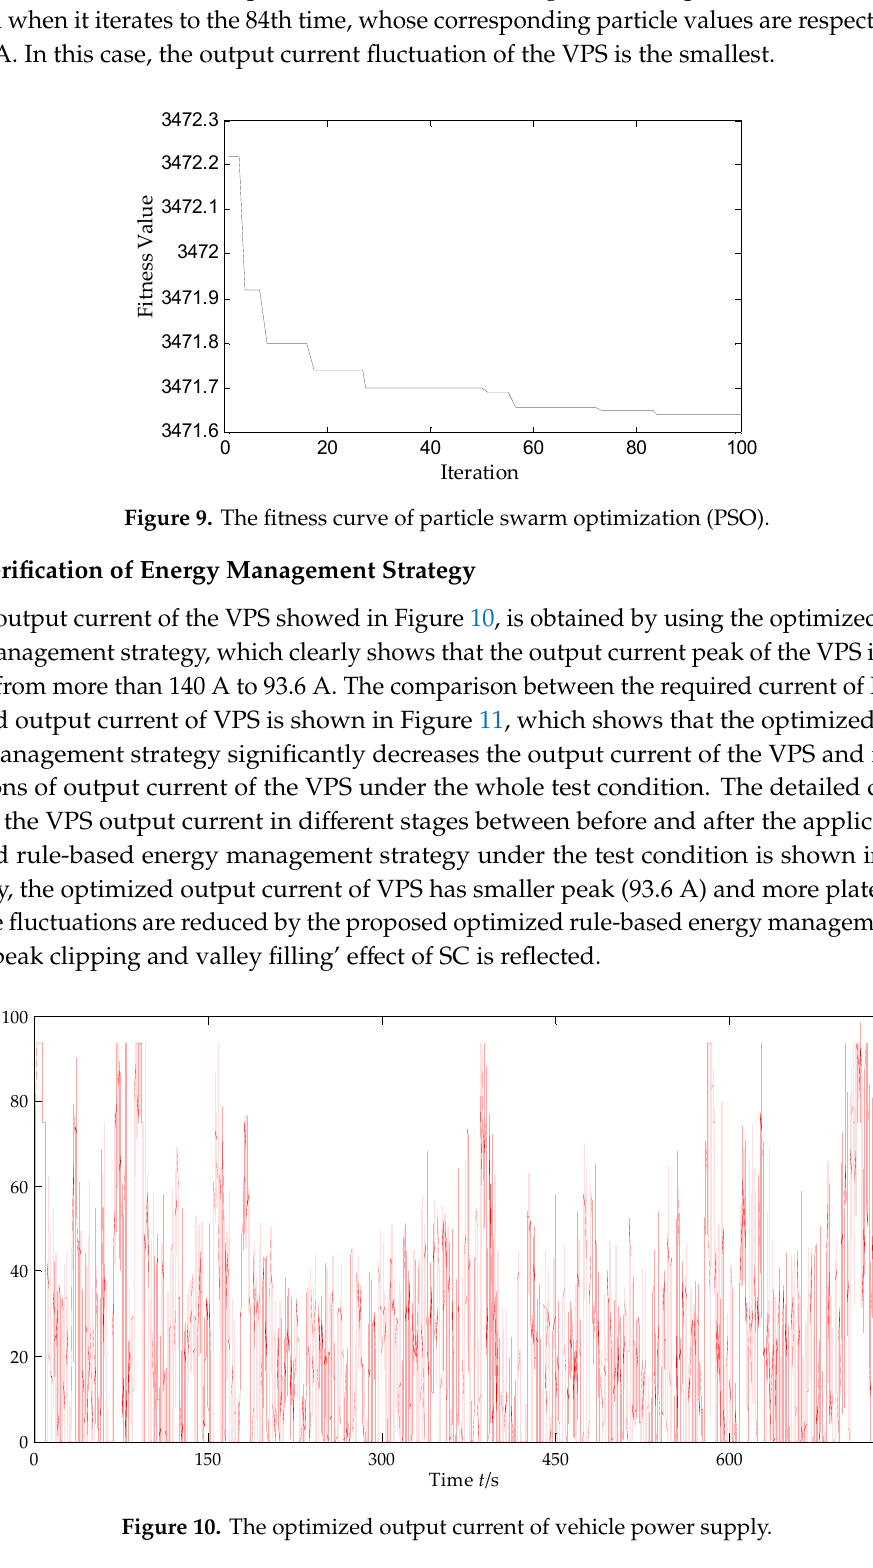
Figure 8. The required current of EPS under the test conditions.